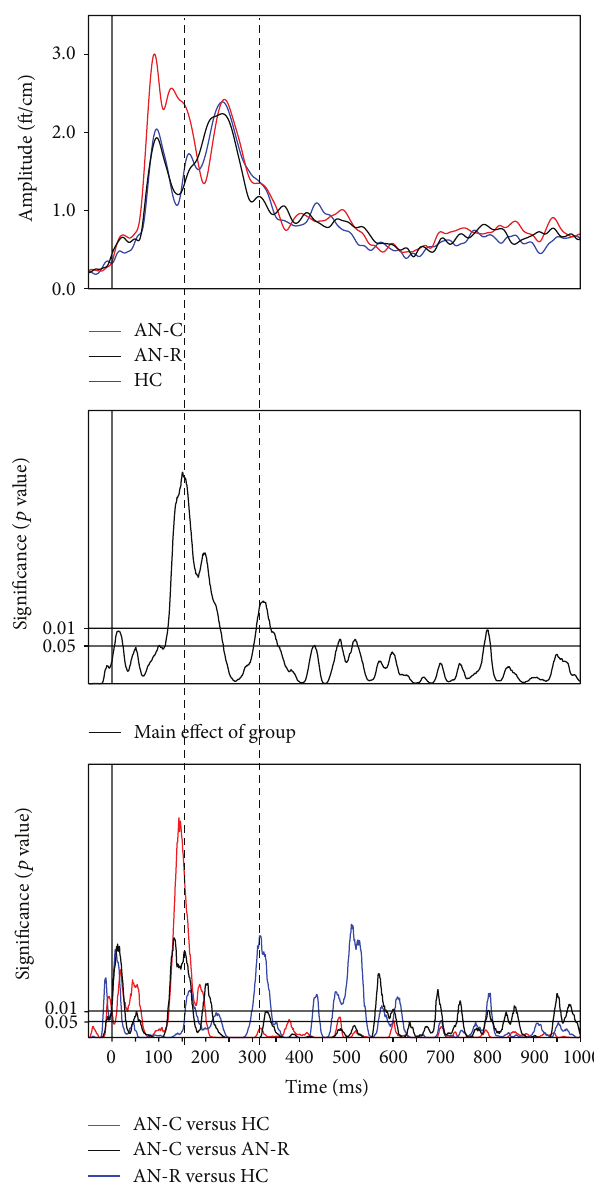
Figure 2: Group differences in neural activity. The top panel shows the mean amplitude (ft/cm) of neural activity after stimulus (collapsed across food categories) across the experimental groups. The middle panel illustrates the significance levels over time of the ANOVA main effect of group. The bottom panel illustrates the significance levels of post hoc Mann-Whitney 𝑈 test analyses of group differences in mean amplitude of neural activity (collapsed across food categories) shown in the top panel. Note: ------ denotes the two peaks of interest: 150 and 320 milliseconds after stimulus, in which group comparisons were significant to the 𝑝 < 0.01 level (see Methods for justification of peak selection). AN-C: acute Anorexia Nervosa group, AN-R: recovered Anorexia Nervosa group, and HC: healthy control